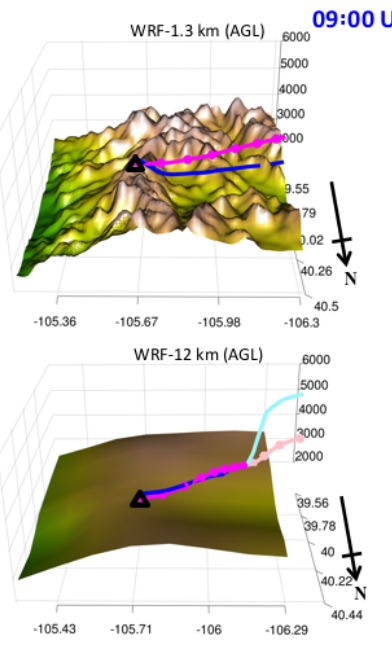
Figure 11. Similar to Fig. 9, but for the Niwot Ridge (NWR)